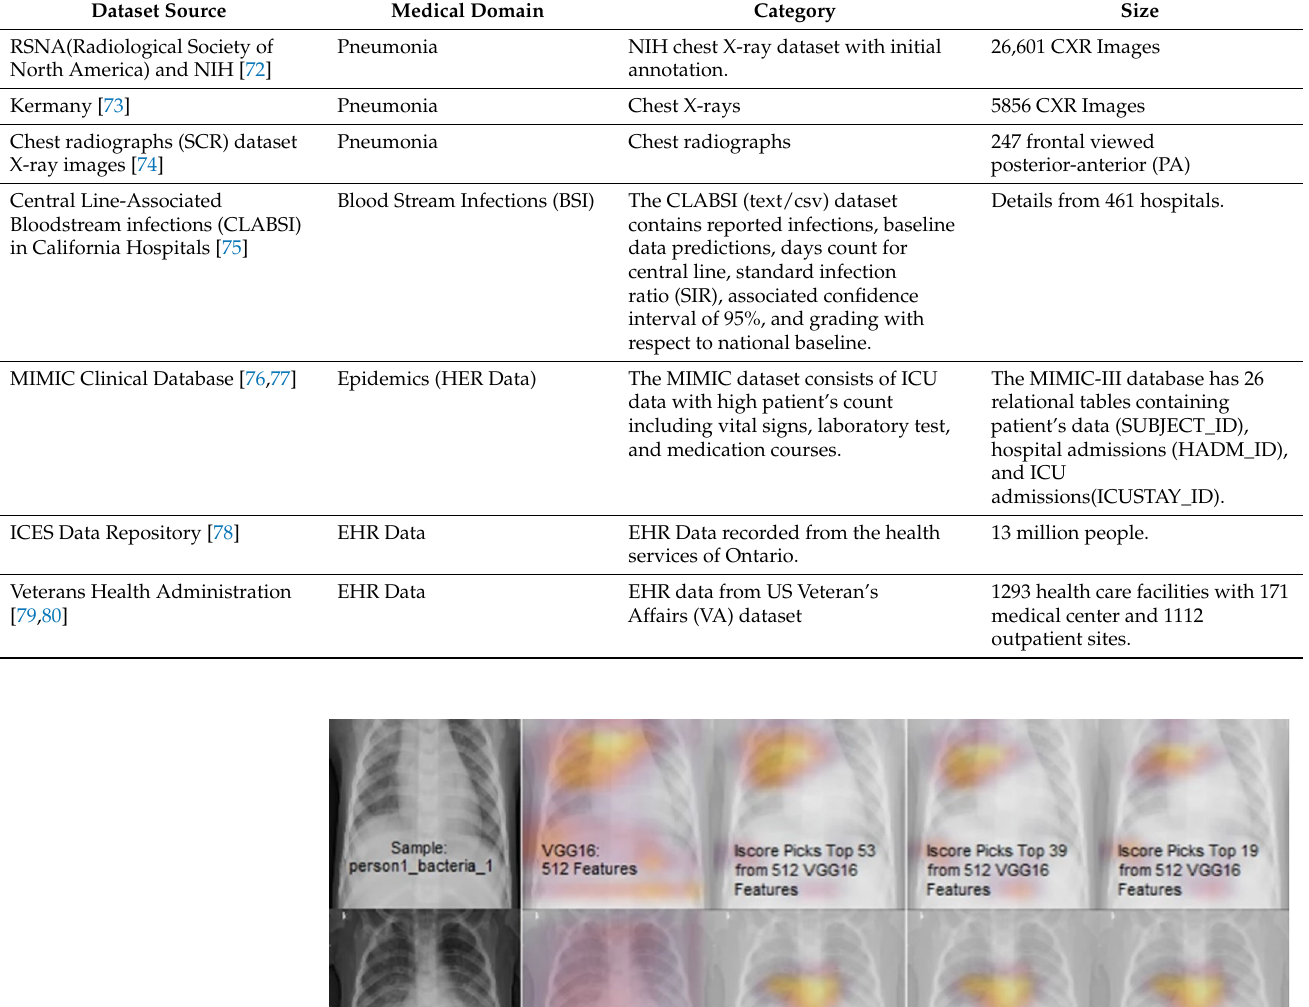
Table 6. Publicly available dataset for medical experiments.